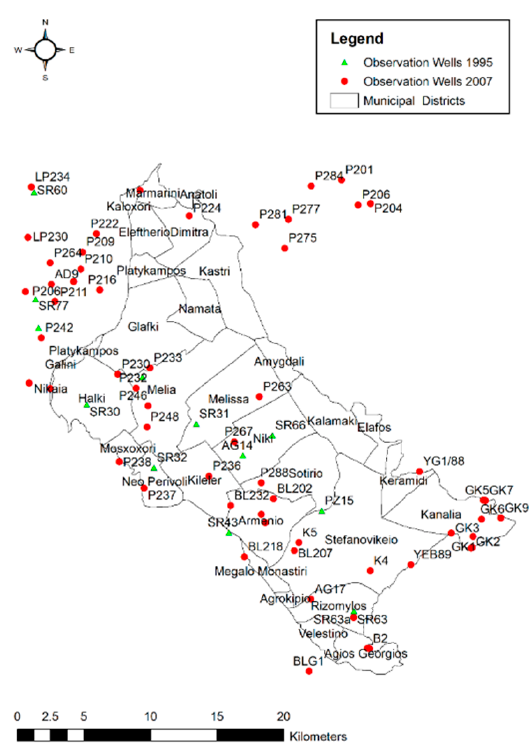
Figure 4. Location of observation wells for the simulation period.